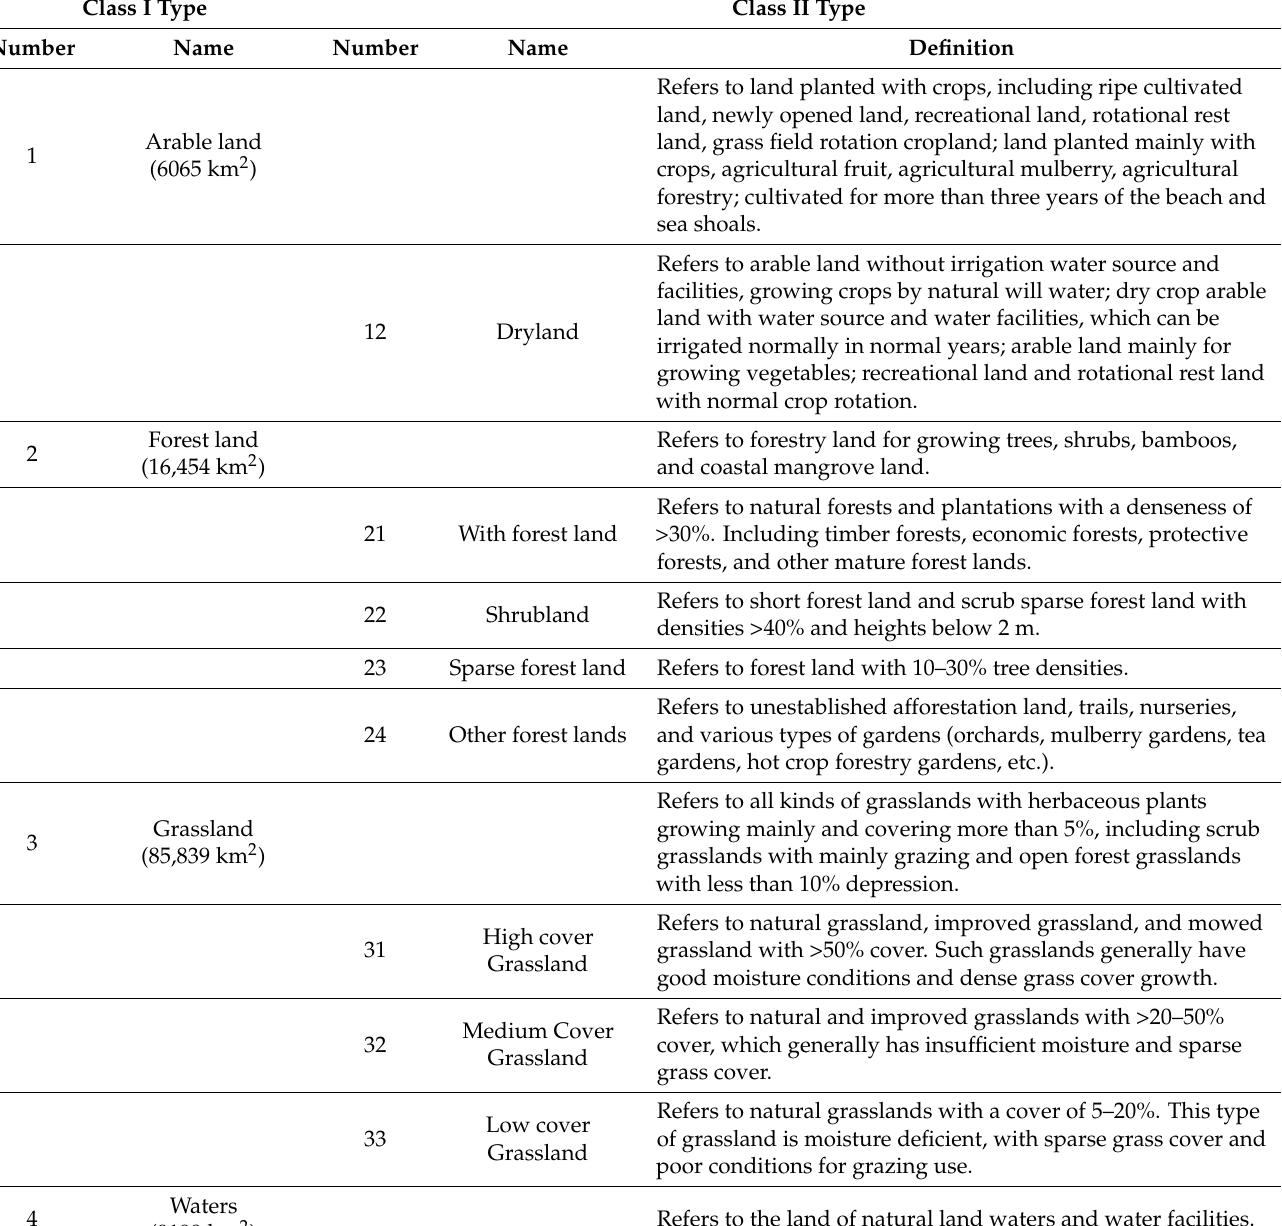
Table 1. Classification systems of LUCC in the Qilian Mountains